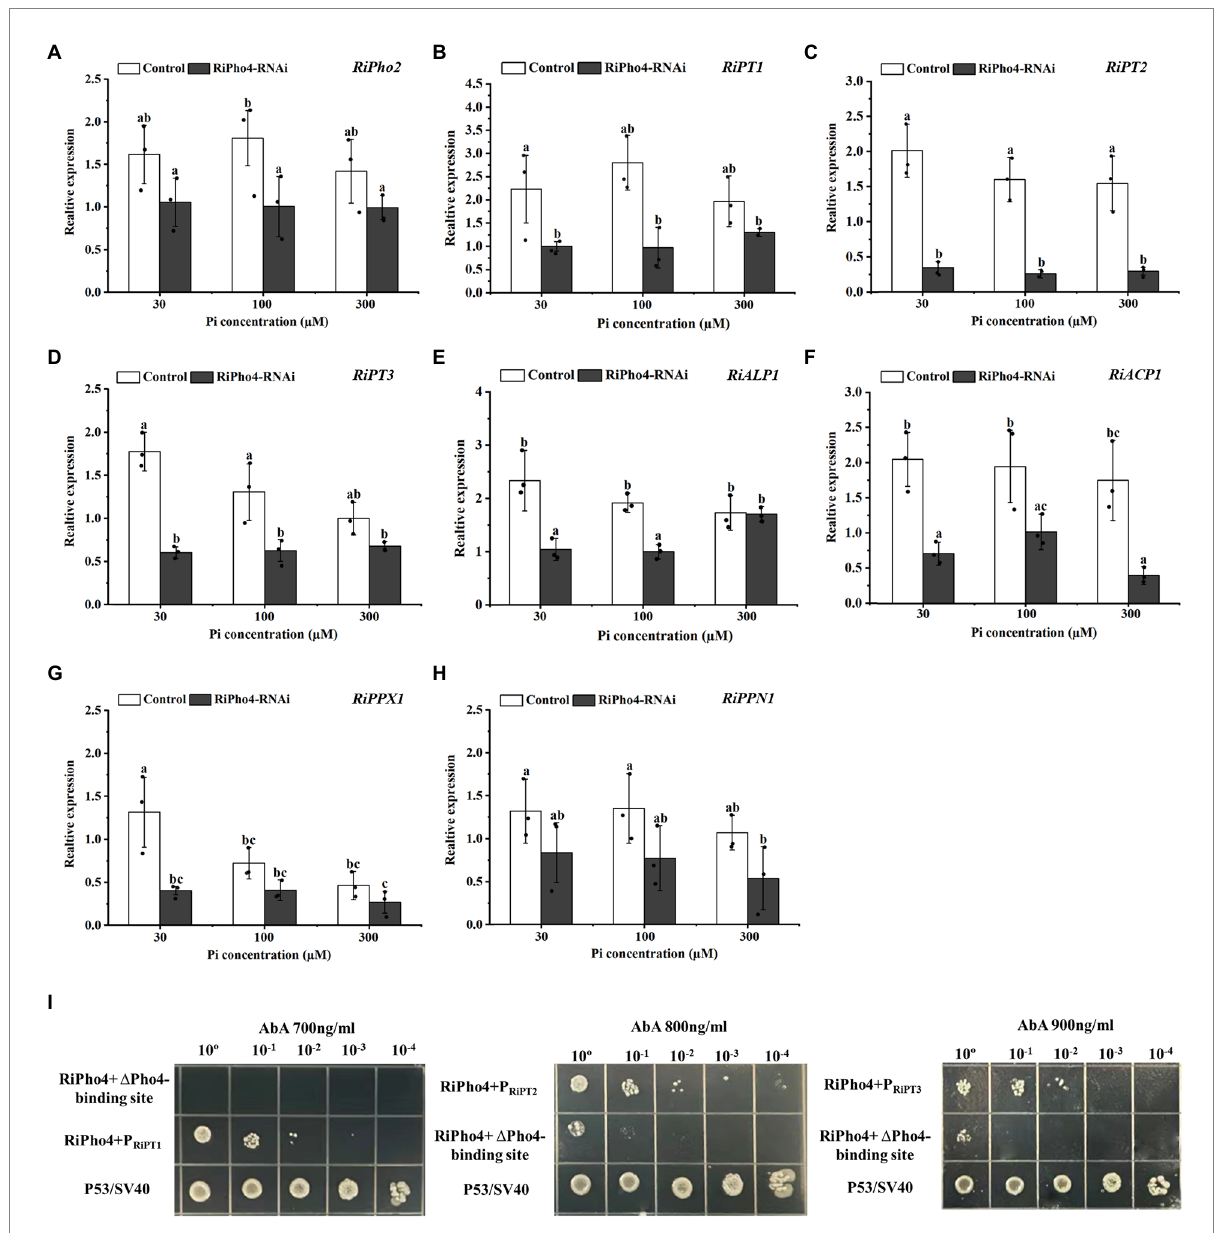
FIGURE 8 RiPho4 regulates the expression of downstream genes involved in Pi transport and metabolism processes in R. irregularis . (A–H) Expression analysis of R. irregularis genes engaged in PHO pathway between RiPho4-RNAi and control roots under different phosphate concentrations. Expression levels of RiPho2 (A) , Pi transport genes RiPT1, RiPT2, RiPT3 (B–D) , phosphatase related genes RiALP1, RiACP1 (E-F), RiPPX1 and RiPPN1 related to Poly-P metabolism (G,H) in response to different phosphate concentrations were estimated by real-time qRT-PCR analysis. Different letters indicated significant differences between control and RNAi lines. The differences between samples were analyzed using Duncan’s new multi-range test at the alpha = 0.05 level. (I) Yeast one-hybrid analysis of the interaction between RiPho4 with promoters of RiPT1 , RiPT2 , and RiPT3 . The promoter regions of RiPT1 , RiPT2 and RiPT3 containing the cis -acting elements CACGTG/T named P RiPT1 , P RiPT2 , and P RiPT3 . The identification of interaction between RiPho4 and the promoter of RiPT1 , RiPT2 , or RiPT3 under the screened even higher AbA inhibition concentration indicated in Fig. S4. Yeast cells carrying both pGBKT7-P53 and pGADT7-SV40 grown on SD/ − Leu were used as the positive control, P RiPT1, P RiPT2, P RiPT3 - Δ Pho4-binding sites with pGADT7-RiPho4 were used as the negative controls. Δ Pho4-binding site indicates the deletion of the Pho4 binding site (CACGTG/T) elements located in P RiPT1, P RiPT2, P RiPT3 promoters. 10-fold serial dilutions of yeast cells were spotted on plates, and the initial yeast concentration was OD 600 =